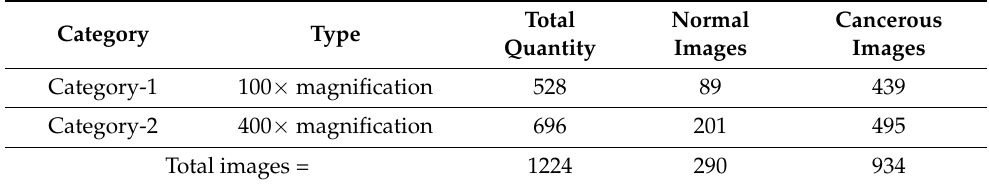
Table 1. Distribution of